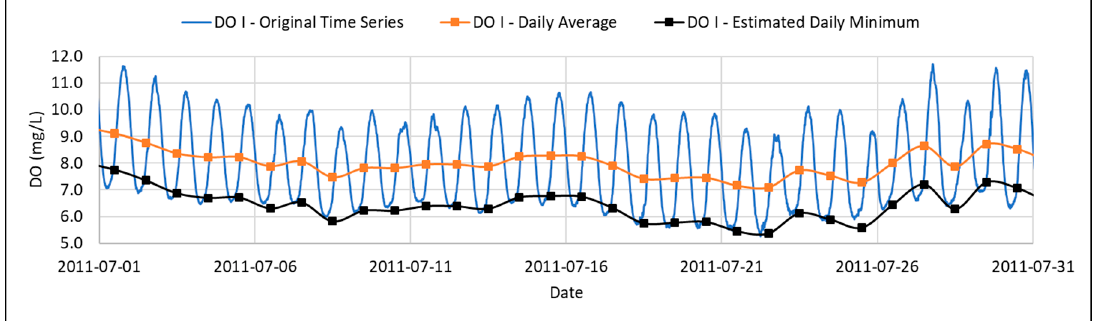
Figure 11. Relationship between diurnal DO cycle, DO daily average, and estimated DO daily minimum based on linear correlation.